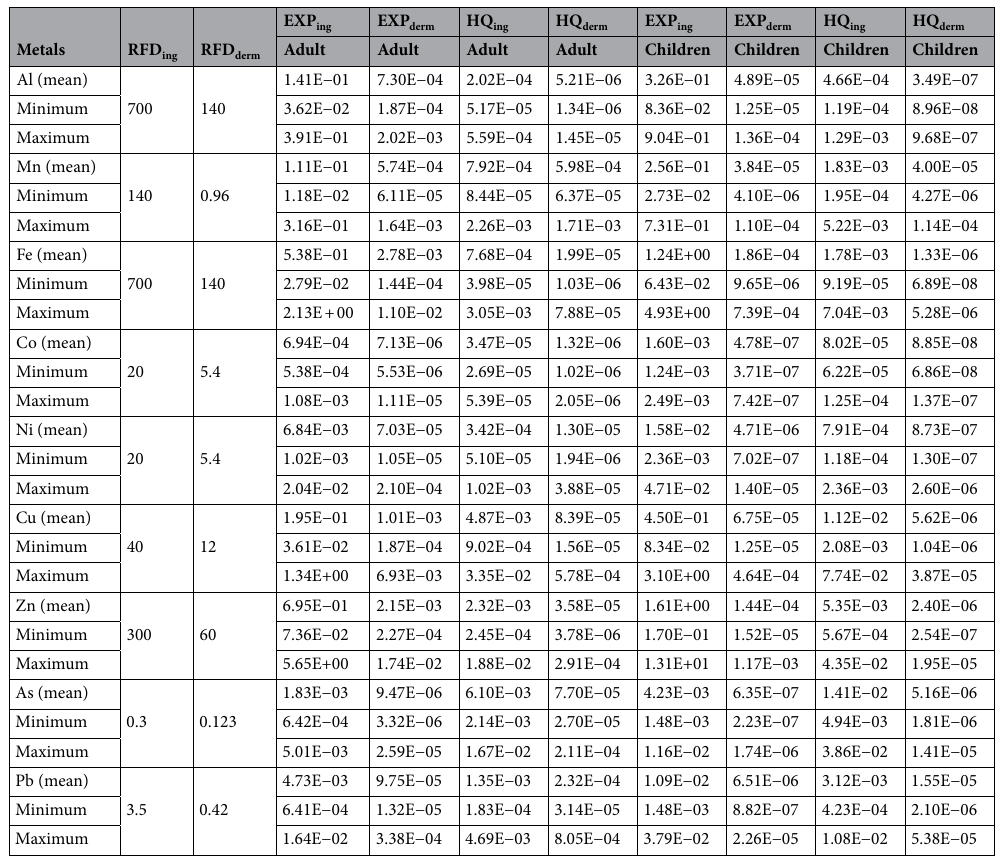
Table 9. Reference dose (µg/kg/day) of metals, exposure dosage and hazard quotient (HQ) for ingestion and dermal pathway.